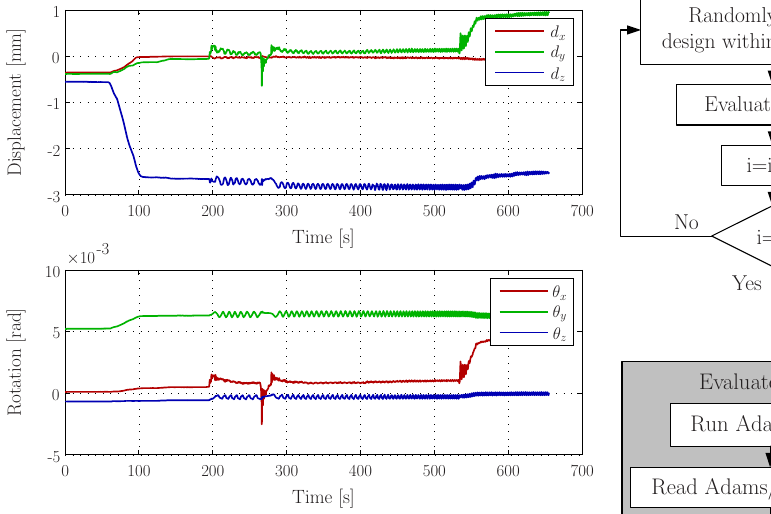
Figure 7: Data used in the parameter identification The derived gearbox rigid body motion is plotted in Figure 7.